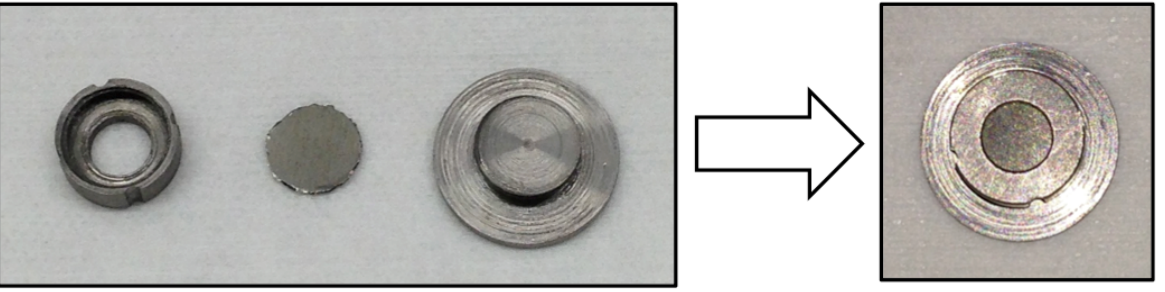
Figure 1. Photograph of the disassembled ( left ) and assembled ( right ) Y foil target and Nb target